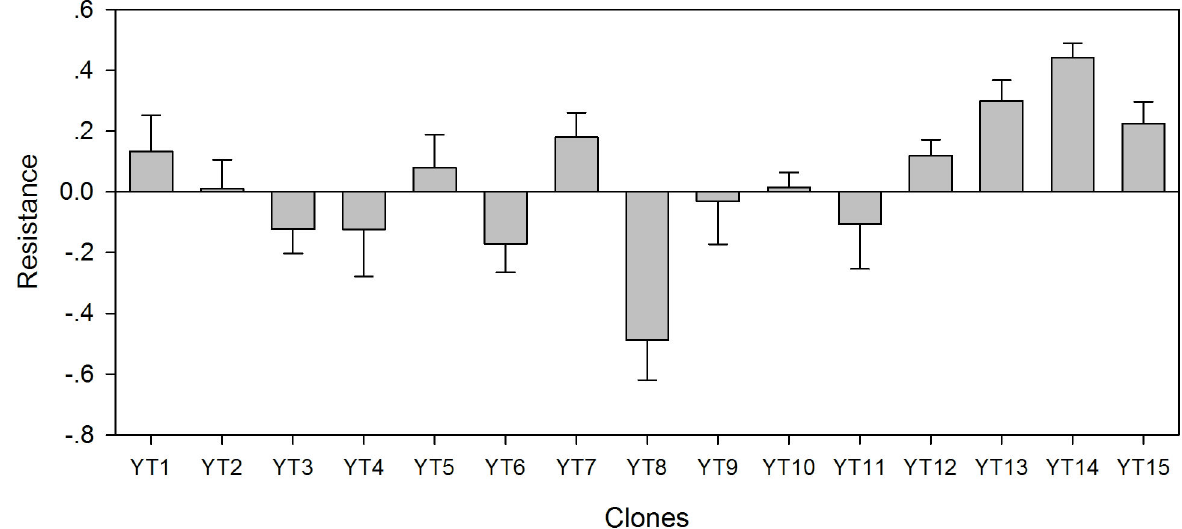
Figure 2. Resistance index (means + SD) of 15 sympatric Bosmina longirostris clones to toxic Microcystis aeruginosa . doi: